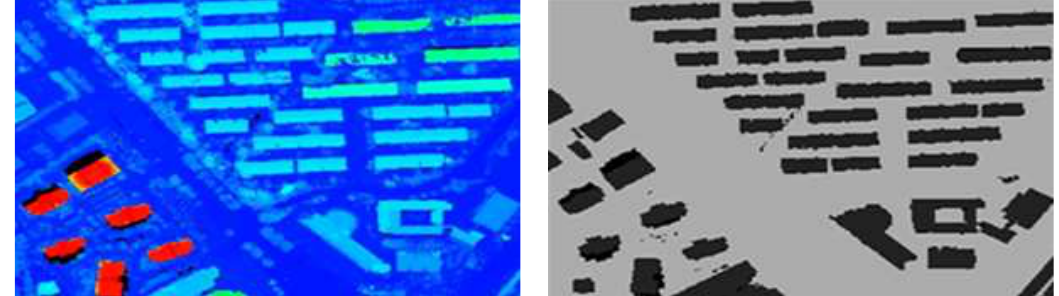
Figure 5. MDR elevation coloration and manual extraction results.